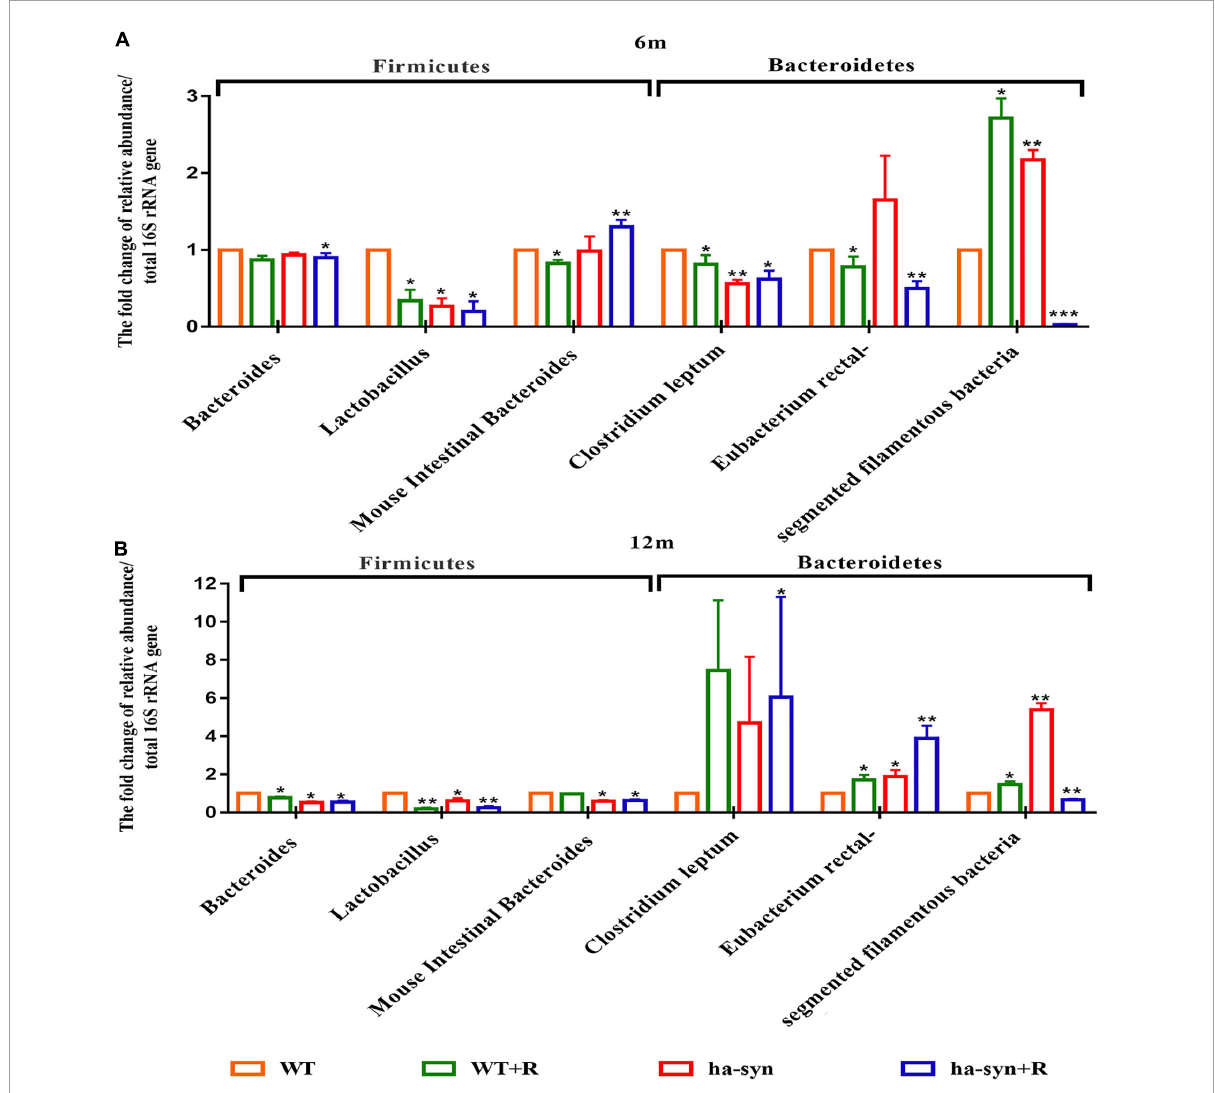
FIGURE5 The effect of rotenone on the intestinal bacteria of h α -syn + / − mice. The changes of specific intestinal bacteria in the mice feces of different ages were detected by qPCR. (A) Changes of specific beneficial and harmful bacteria in the small intestine of 6-month-old h α -syn + / − mice. (B) Changes of specific beneficial and harmful bacteria in the small intestine of 12-month-old h α -syn + / − mice. n = 6. * P < 0.05, ** P < 0.01, *** P < 0.001, compared with the age-matched WT